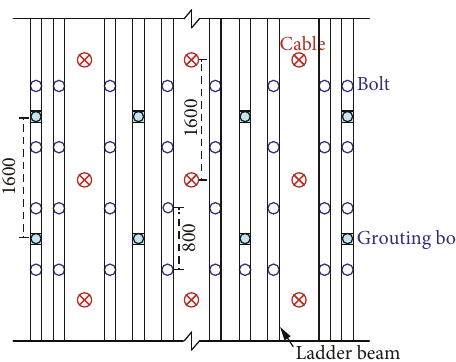
Figure 10: Arrangement of bolts and cables in the track rise.